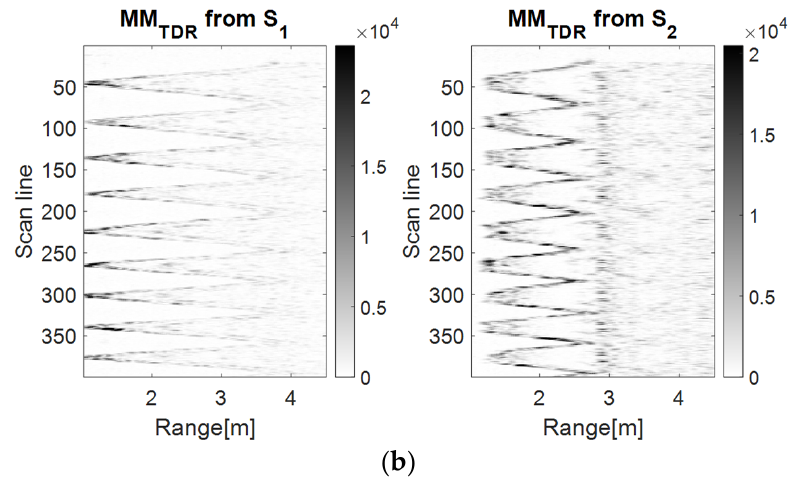
Figure 6. The drone ( a ) and the human ( b ) forward–back movement maps using the TDR method with m = 5, d = 1.